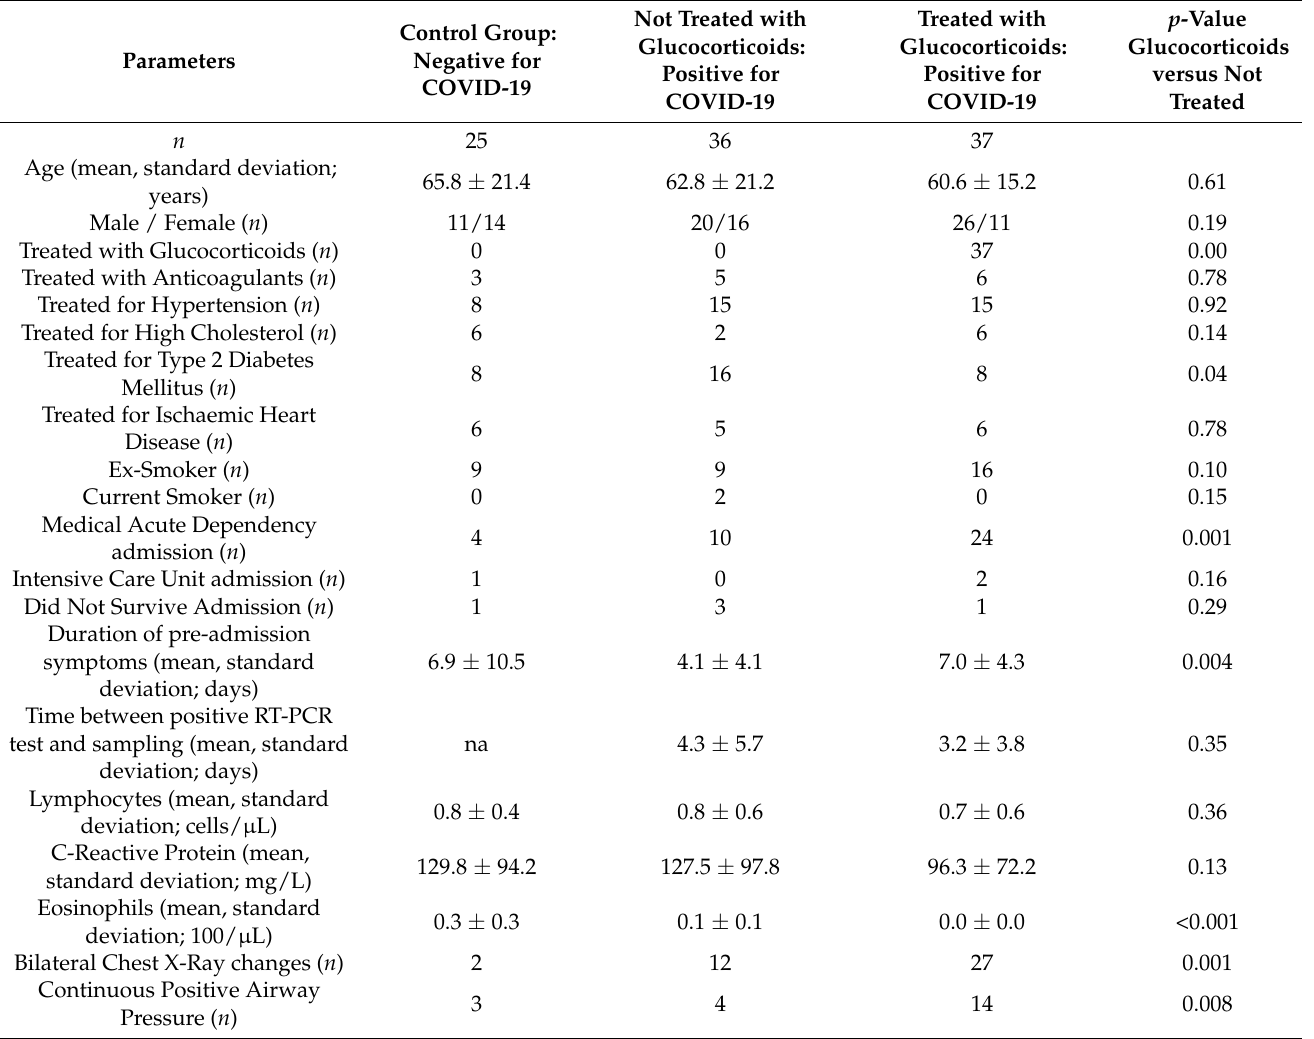
Table 1. Characteristics of study population. P-values are shown for the positive for COVID-19: treated with glucocorticoids group compared with the positive for COVID-19: not treated with glucocorticoids